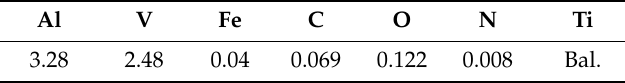
Table 1. Chemical composition of Ti-3Al-2.5V powder (mass%).